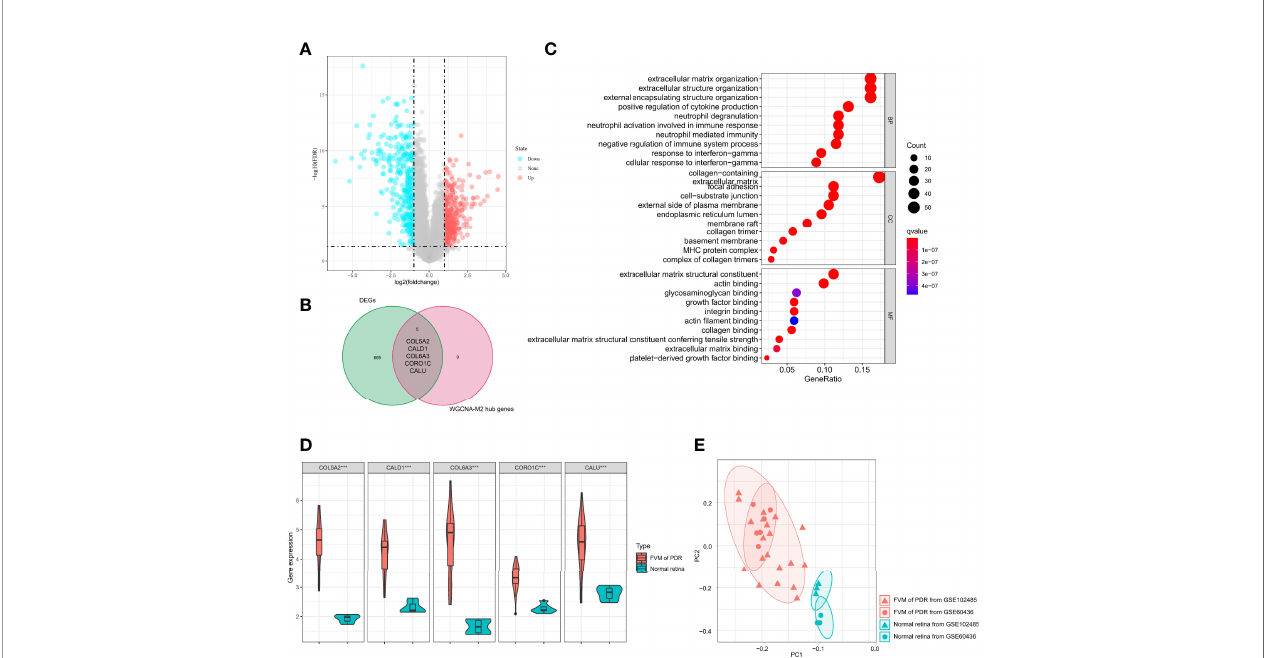
FIGURE 5 | Identi fi cation of M2 macrophage-related biomarkers. (A) Volcano plot of DEGs between the FVM and control group. (B) Venn diagram of intersection genes between DEGs and M2 macrophage-related genes. (C) Bubble plots of GO enrichment analysis with fi ve possible biomarkers. (D) Violin plot of expression levels of selected fi ve genes in the FVM and normal retina group (***p<0.001). (E) PCA plot of 32 samples from two datasets (based on selected fi ve genes, different shapes indicate different datasets, different colors indicate different sample